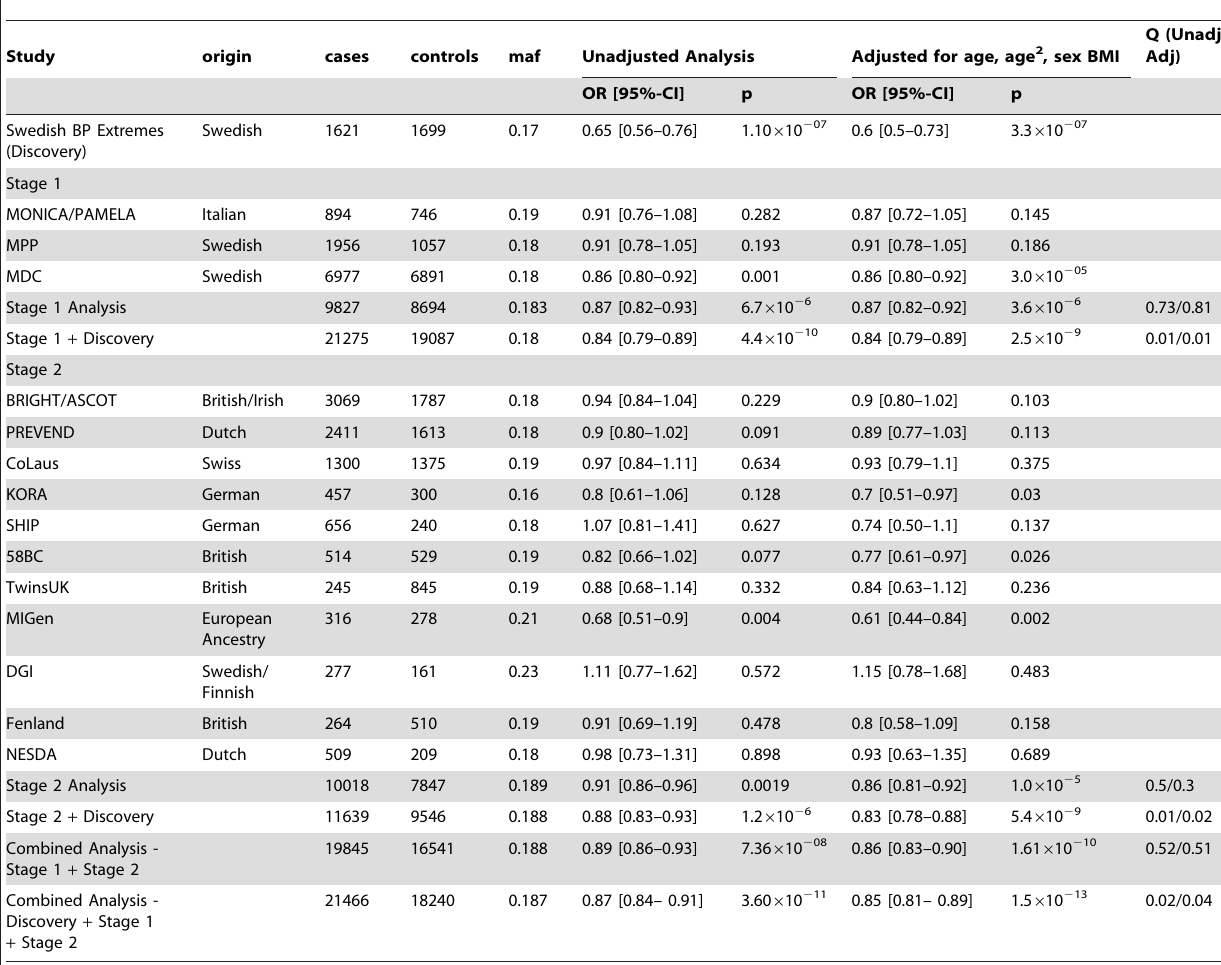
Table 2. Results from the meta-analysis of rs13333226 and HTN in discovery sample and after